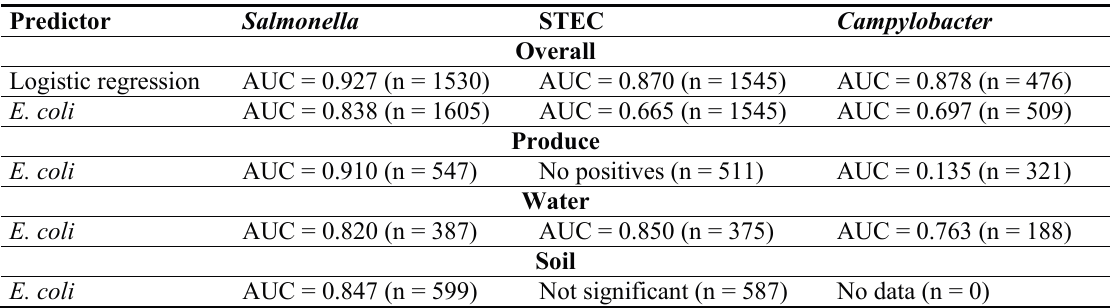
Table 3. Receiver Operating Characteristic (ROC) curve analysis of each index for each pathogen per sample type, showing the area under the curve (AUC) and number of samples (N) on which the ROC analysis was